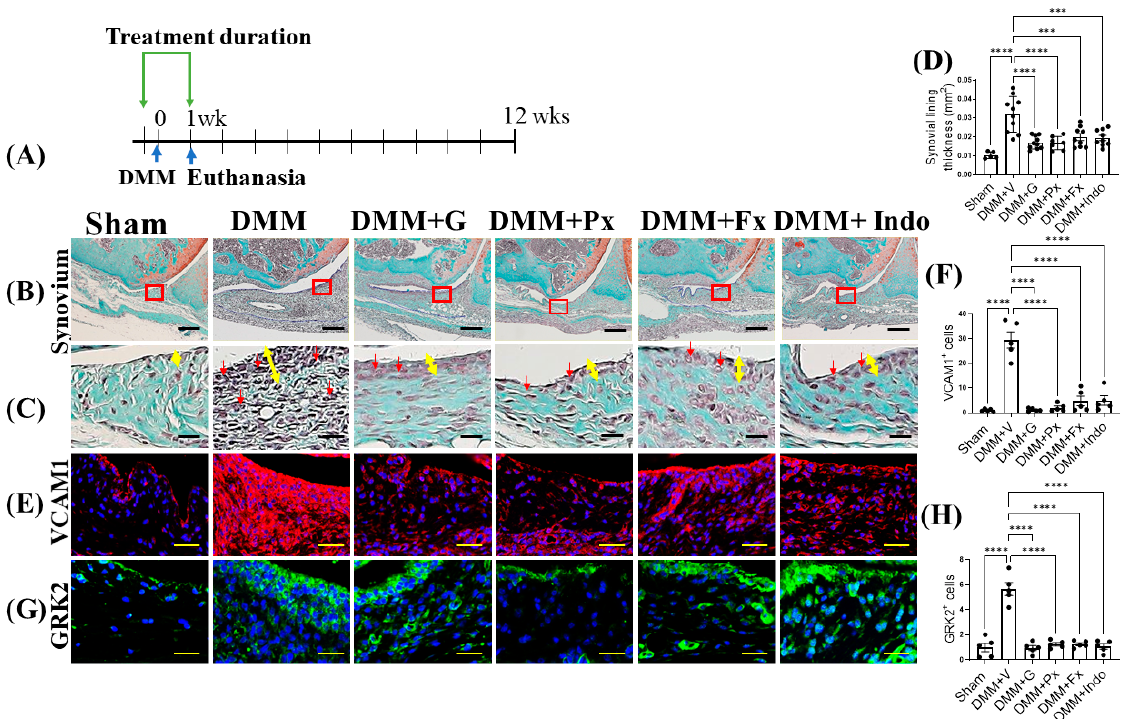
Figure 3. Early continuous G βγ -GRK2 inhibition attenuates synovitis in early-stage PTOA. ( A ) Schematic representation of timeline of drug treatment after sham ( n = 5) or DMM surgeries. Two days before surgery, mice started receiving daily intraperitoneal injections of vehicle (V; n = 10), gallein (G; 10 mg/kg per day, n = 10), paroxetine (Px; 5 mg/kg per day, n = 7), fluoxetine (Fx; 5 mg/kg per day, n = 9), or indomethacin (Indo; 2.5 mg/kg per day, n = 9). All mice were euthanized 1 week after surgery. Green arrows denote the duration of treatment. ( B ) Representative images of Safranin- O/Fast Green staining of the anterior femoral synovial region of mouse knee sections 1 week after DMM or sham surgery; scale bar, 50 µm. ( C ) Magnified images of regions indicated in red boxes in (B); scale bar, 10 µm. Yellow double-headed arrows depict synovial lining thickness, and red arrows indicate synovial inflammatory cells. ( D ) Quantification of anterior femoral synovial membrane thickness. Representative IF staining images showing ( E ) VCAM1 (red) and ( G ) GRK2 (green) in the anterior femoral synovium. DAPI (blue) stains nuclei; scale bar, 50 µm. Quantification of the per- centage of positive cells expressing ( F ) VCAM1 and ( H ) GRK2. n = 5 per group; *** p < 0.001 and **** p < 0.0001 vs. DMM + V group using one-way ANOVA. Values are expressed as means ± SEM.